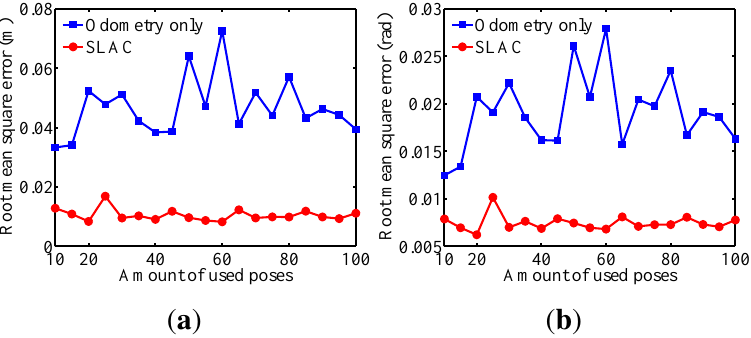
Figure 10. Robot’s pose for different amounts of used poses. We can notice that both the position and orientation of the robot were improved with the proposed